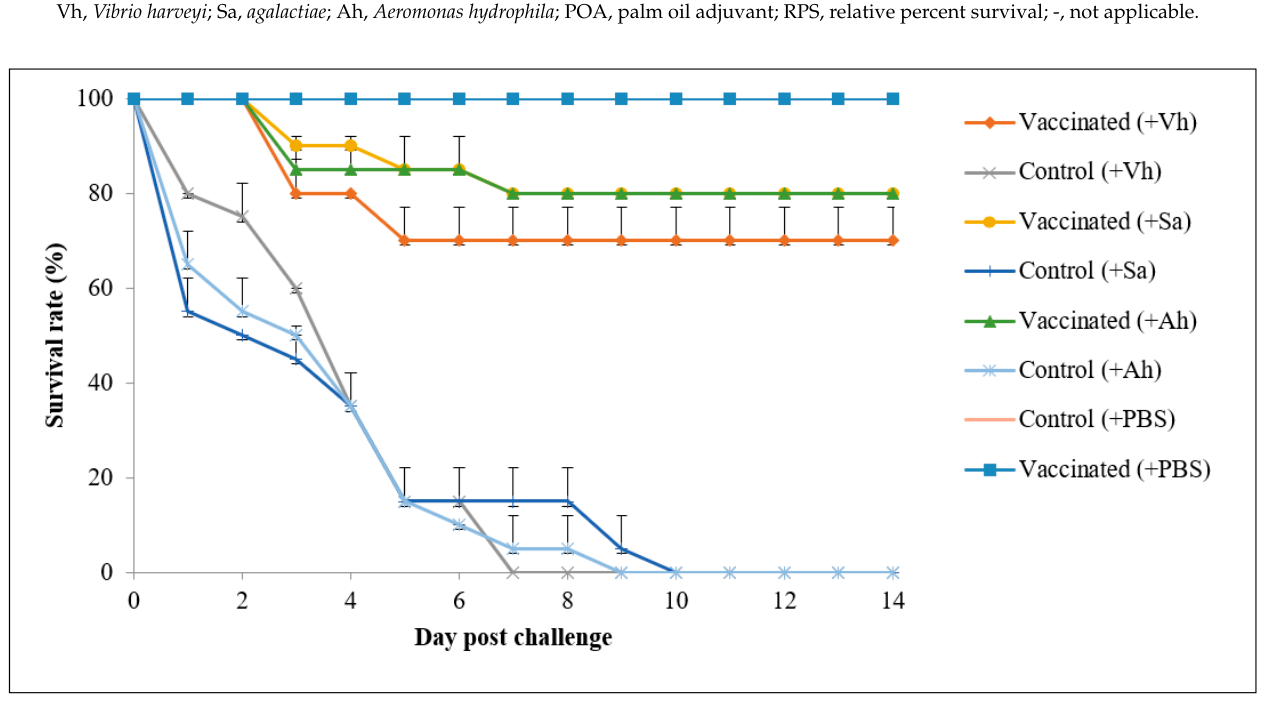
Figure 10. The survival rate of Asian seabass from vaccinated and non ‐ vaccinated control groups after challenging with V. harveyi (+Vh), S. agalactiae (+Sa), A. hydrophila (+Ah), and PBS buffer (+PBS). Each treatment was performed in duplicate with 10 fish per tank. The upper half part of the standard deviation bars is shown.